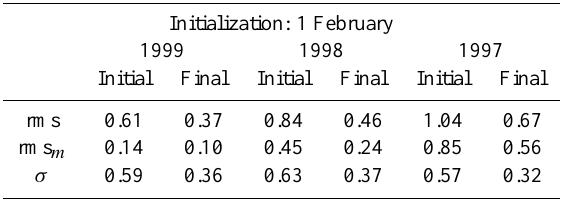
Table 1. Comparison of temperature errors ( ◦ C) in the assimila- tion run, computed for the whole basin and layer L1 using sampling strategy T7, with different initial conditions. See text for the expla- nation of symbols